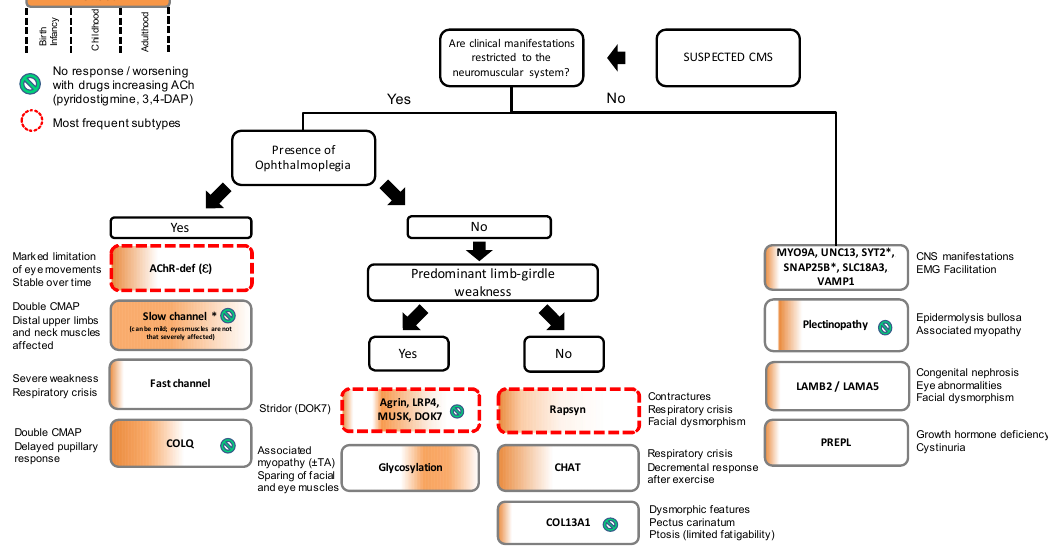
Figure 2. Proposed algorithm for targeted genetic screening of suspected CMS cases. Clinical evaluation should start by exploring age at onset and presence of manifestations beyond the neuromuscular boundaries. Ophthalmoplegia and limb-girdle weakness are clinically useful to guide genetic screening. Key diagnostic features are provided outside the boxes. Most frequent subtypes of CMS include AChR-deficiency, DOK7 CMS, and rapsyn CMS which stand for approximately 70% of all cases in the UK. (*) Slow channel syndrome, SYT2 CMS, and SNAP25B CMS are dominantly inherited. CNS, central nervous system; TA, tubular aggregates.